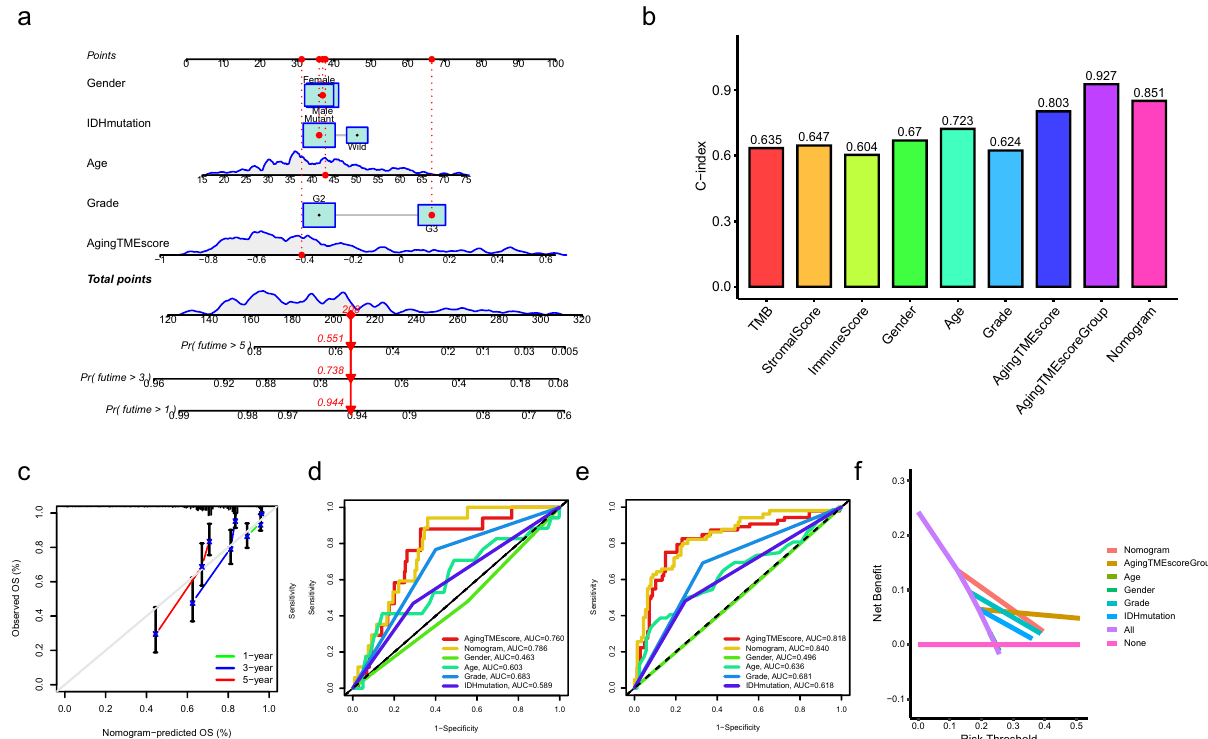
Figure 4. Construction of nomogram model. ( a ) Nomogram model was constructed combining the aging TME score and multiple clinicopathological factors. ( b ) Determination of C-index values of multiple clinicopathological factors. ( c ) Calibration curves for the nomogram model. ( d , e ) ROC curves for the nomogram model and other clinicopathological factors at the time of 1 ( d ) and 2 ( e ) years. ( f ) DCA for the nomogram model and other clinicopathological factors. TME, tumor microenvironment; C-index, consistency index; ROC, receiver operating characteristic; AUC, area under curves; DCA, decision curve